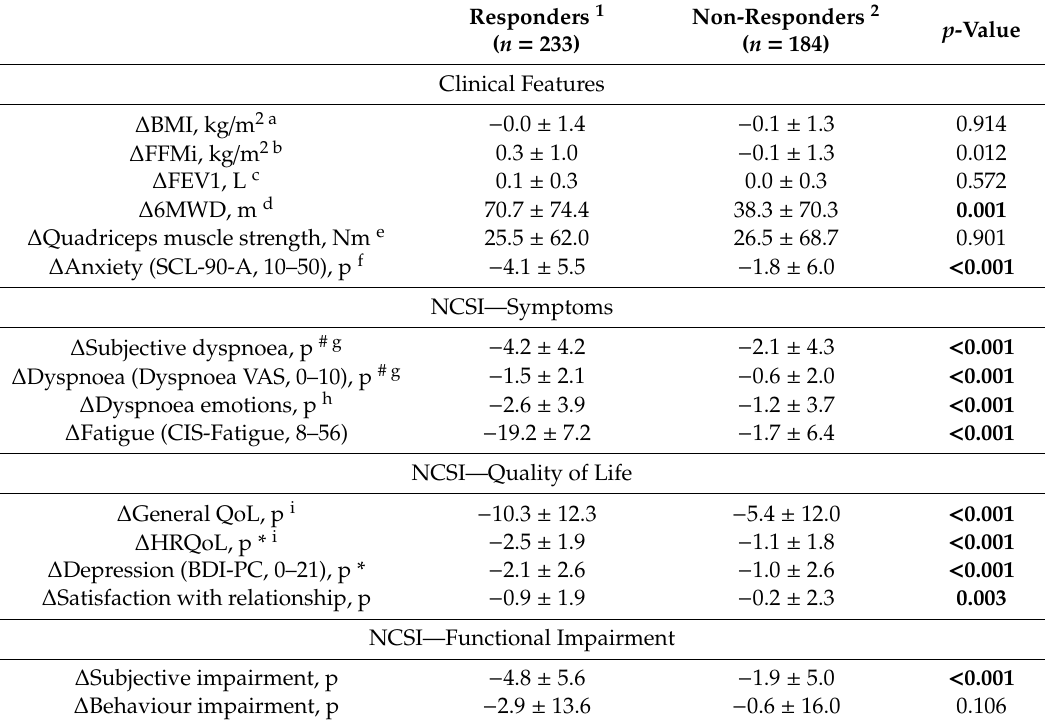
Table 4. Change scores after PR of patients with COPD stratified for response of